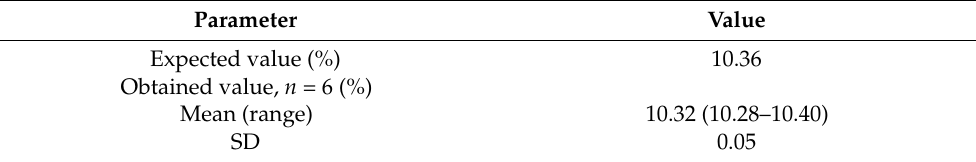
Table 2. Checking the procedure for the quantitative analysis of nitrogen.